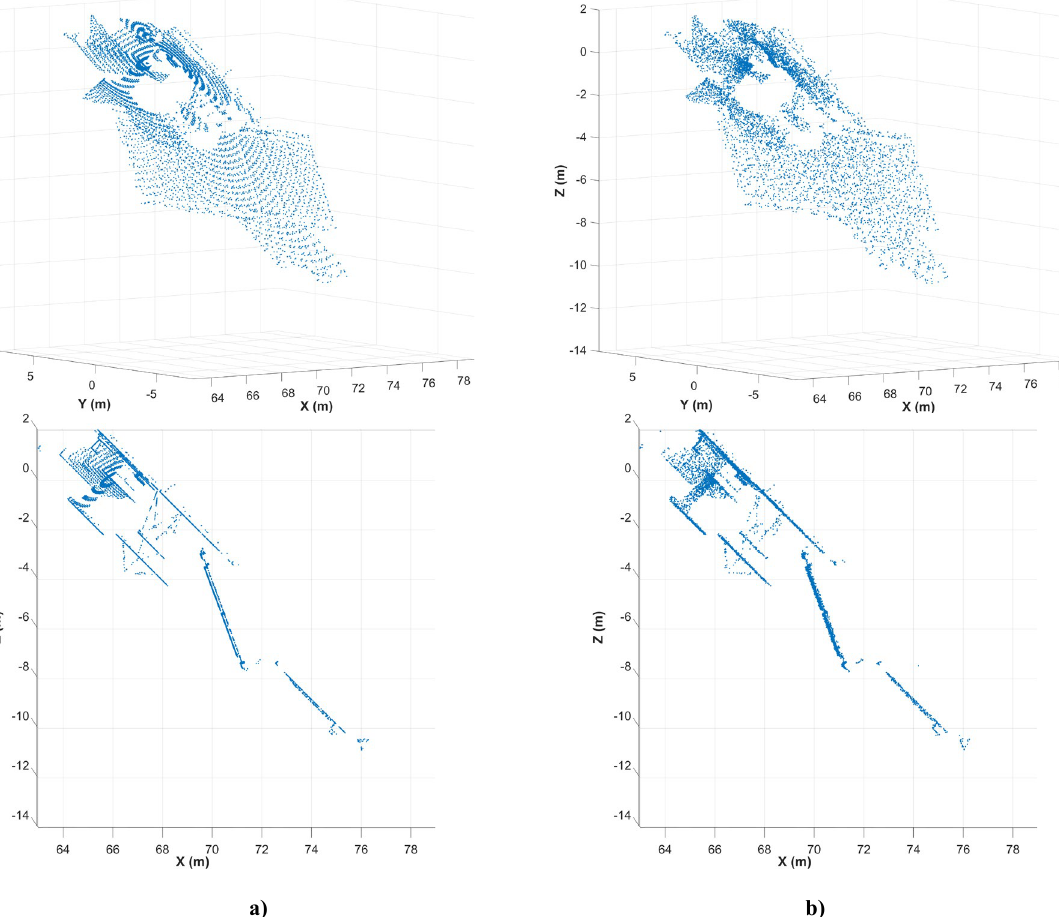
Figure 11. Point clouds generated. a) Point cloud without adding angular and range error. b) Point cloud adding both angular and